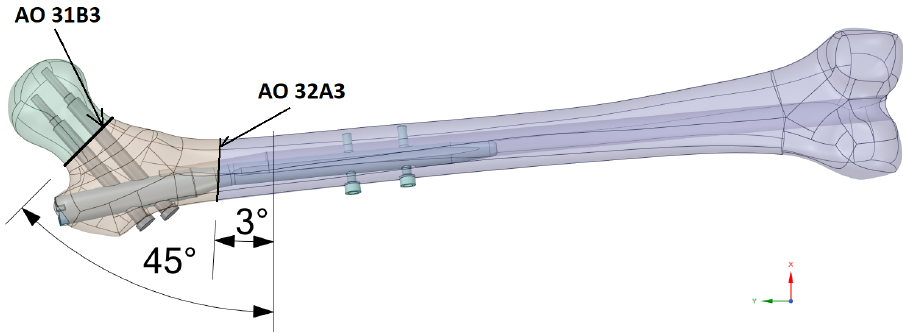
Figure 9. Location of fractures in the anatomical CAD model of the femur (Spaceclaim).